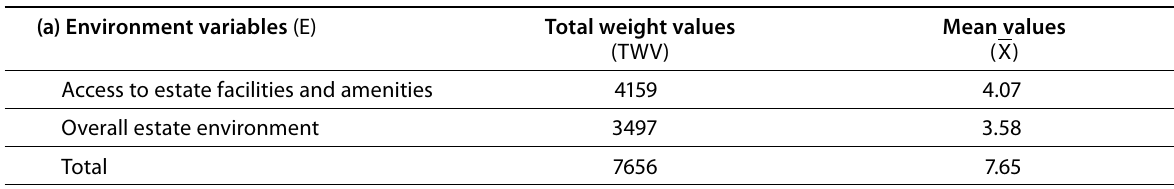
Table 4. evaluation of tenants’ housing satisfaction Variables of housing